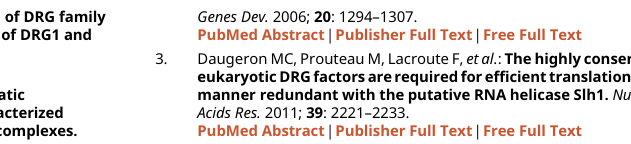
Data are available under the terms of the Creative Commons Zero “ No rights reserved ” data waiver (CC0 1.0 Public domain